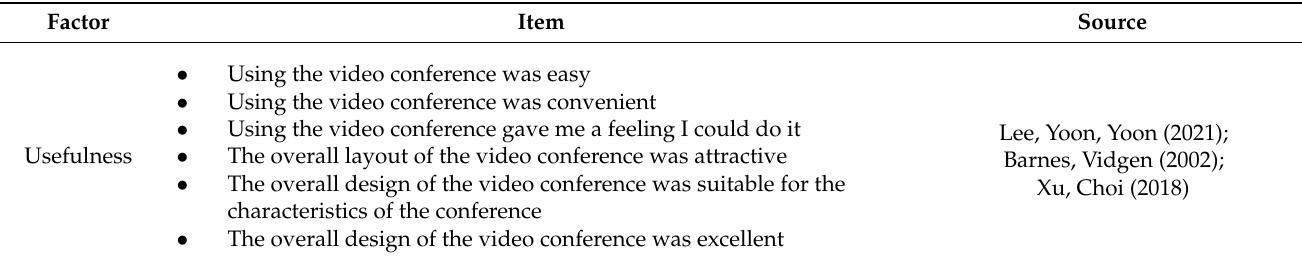
Table 1. Video conference quality.